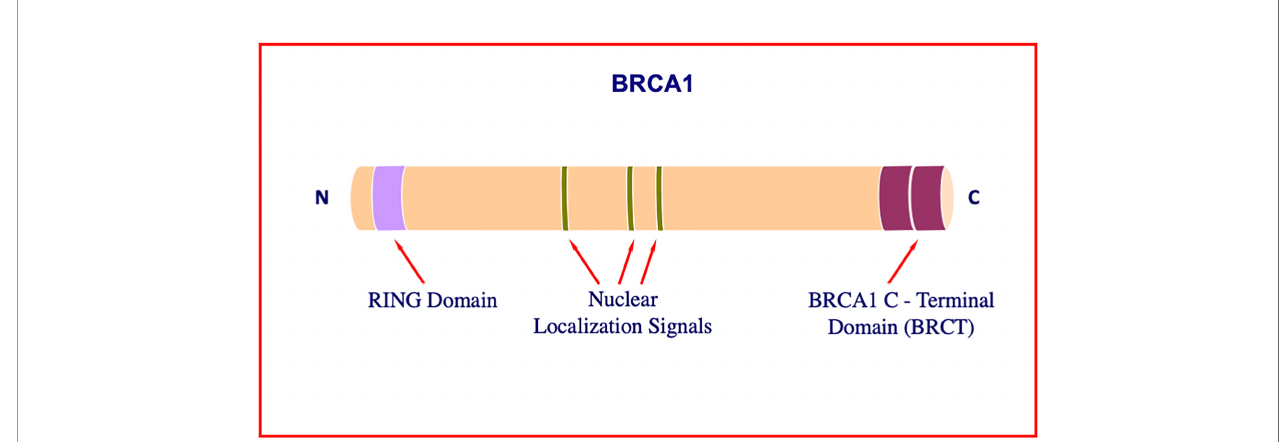
FIGURE 1 | Structure of BRCA1. The BRCA1 gene encodes a 1863-amino acid protein with tumor suppressor activity. BRCA1 plays a critical role in DNA damage sensing and it forms a complex that repairs double-strand breaks. The N-terminal portion of the molecule includes a particular type of zinc fi nger element, termed RING motif. Among other roles, this domain interacts with proteins involved in BRCA1 ubiquitination. The central portion of the molecule includes a number of nuclear localization signals. The tandem C-terminal BRCT domain has important roles in DNA repair, transcription regulation and tumor suppressive